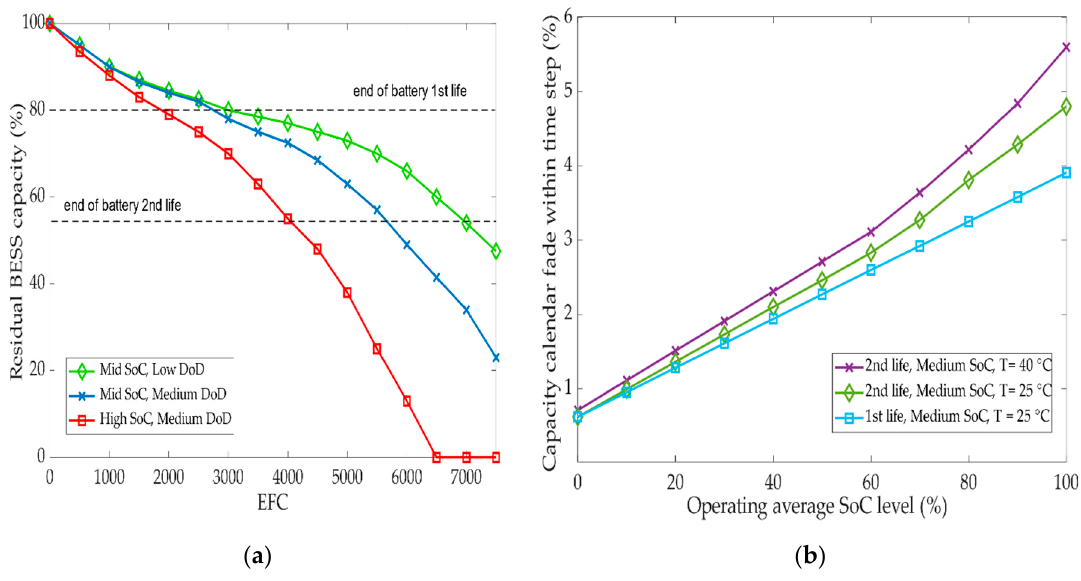
Figure 19. ( a ) The course of degradation of the battery capacity due to cycling dependent on the level of SoC and depth of discharge (DoD) and disposal of the battery when it reaches 55% of the original capacity. ( b ) Comparison of the calendar aging of a new battery and a secondary battery and the effects of the operating temperature within a time step of 10 years.